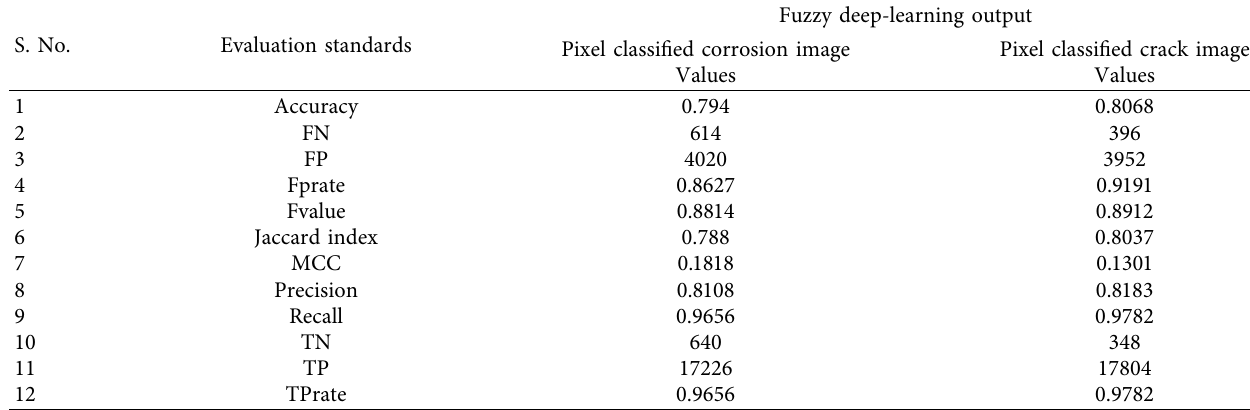
Figure 8: (a) Denoised corrosion image. (b) Pixel classifed corrosion image. Table 3: Evaluation